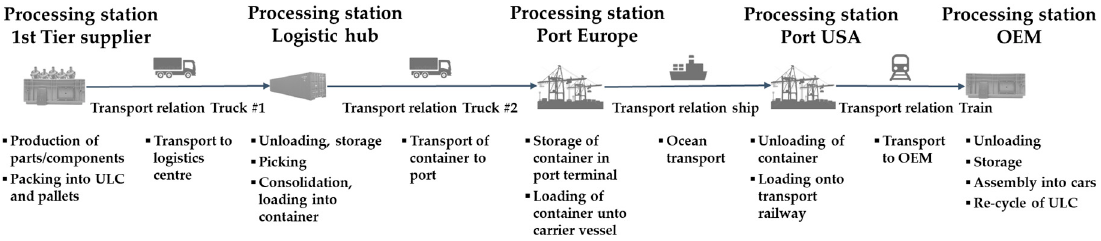
Figure 1. Generic supply chain in the simulation model.